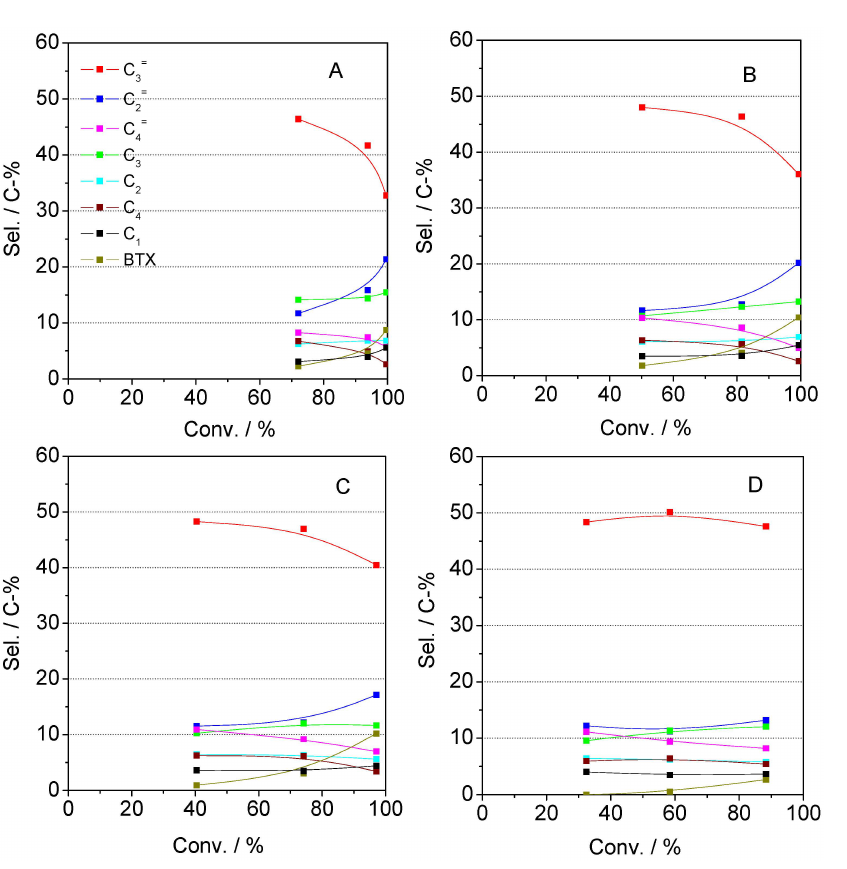
Figure 16. Changes in products’ selectivities with n -hexane conversion on HB(77) ( A ); HB(77)-AT(0.05 M) ( B ); HB(77)-AT(0.2 M) ( C ); and HB(77)-AT(0.05 M)-NT(1 M) ( D ) catalysts. Reaction conditions: see Figure 12. Products abbreviations: see Figure